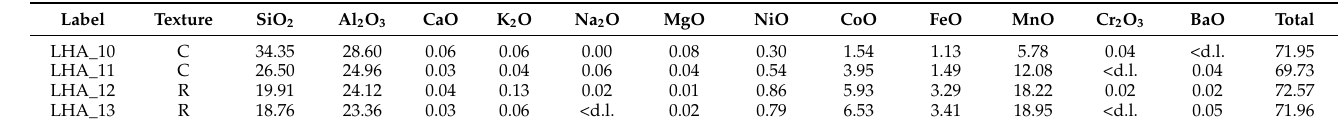
Table 3. Representative EMP analyses (in weight percent) of the studied Co-bearing phyllosilicates from Loma de Hierro (Venezuela). <d.l.: below detection limit; C-core; R-rim.